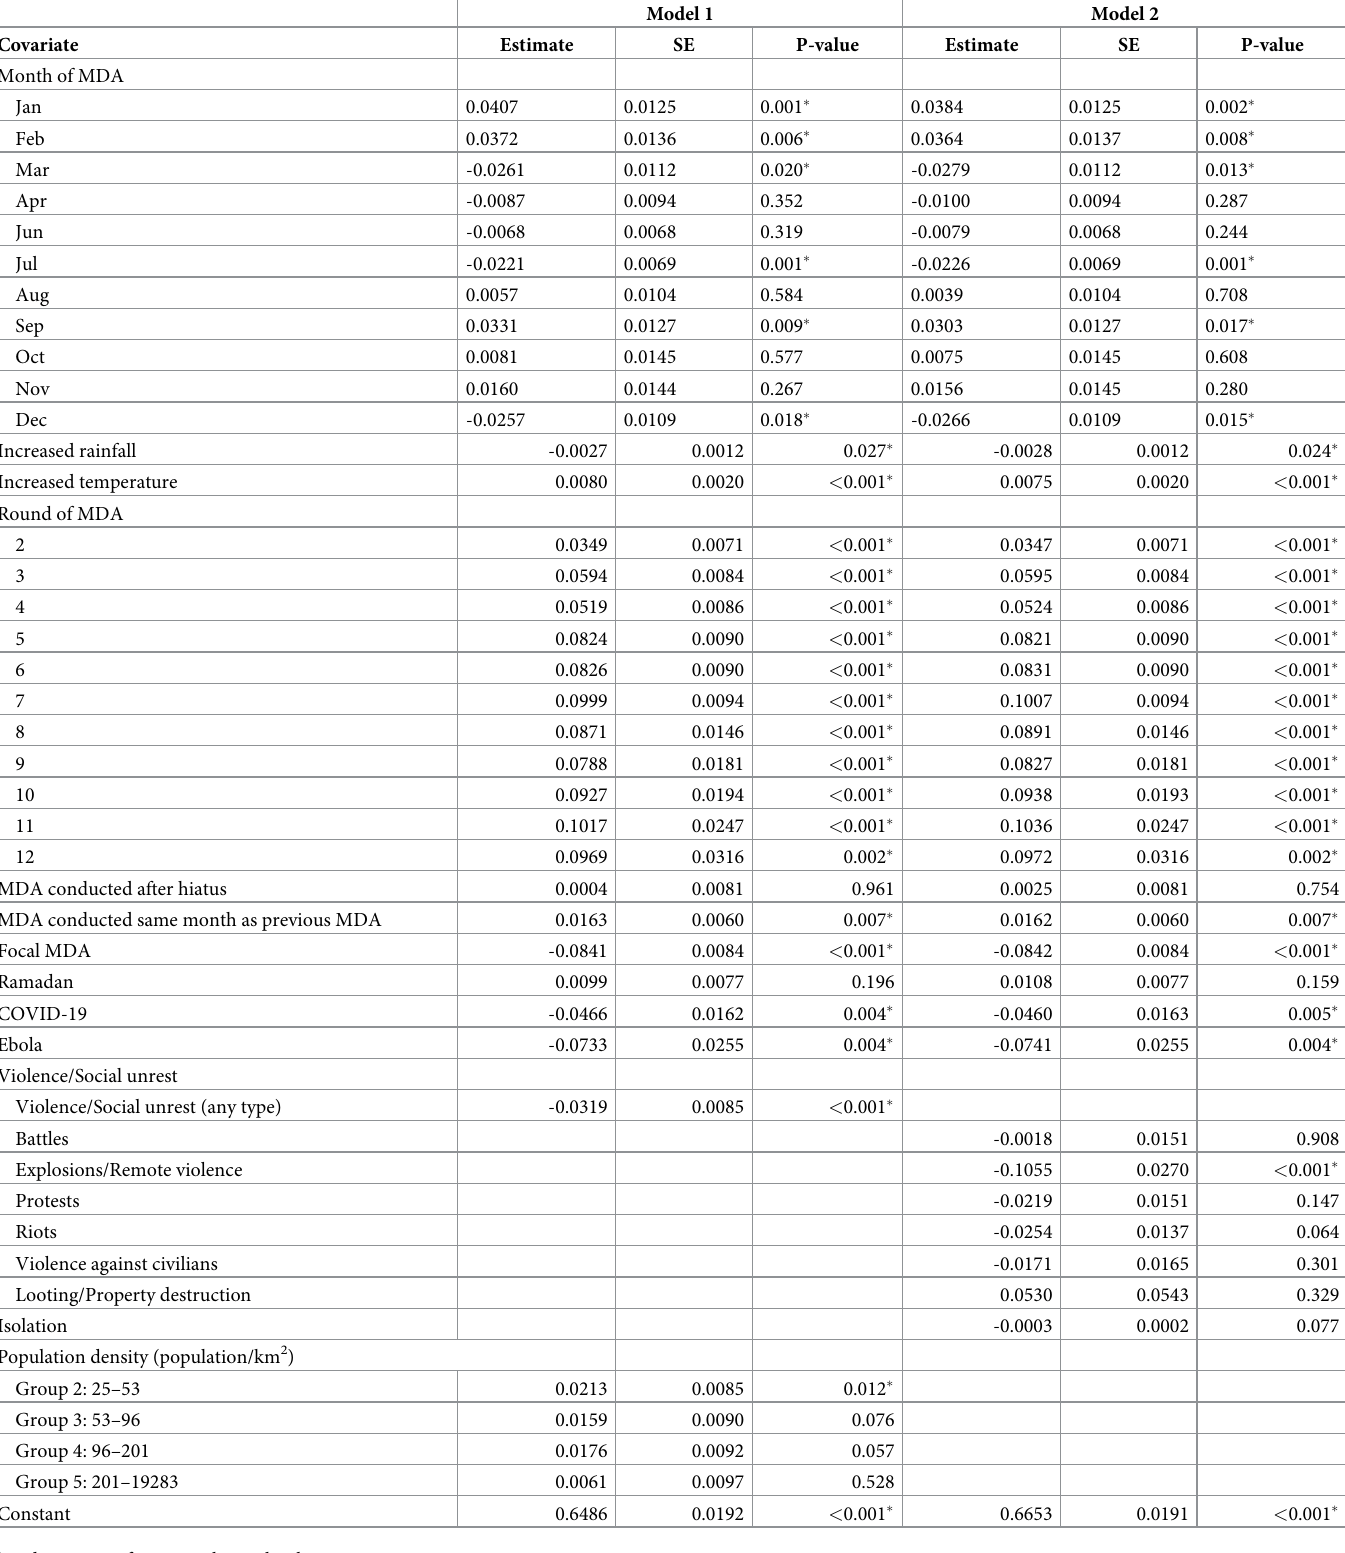
Table 3. Results of hierarchical linear